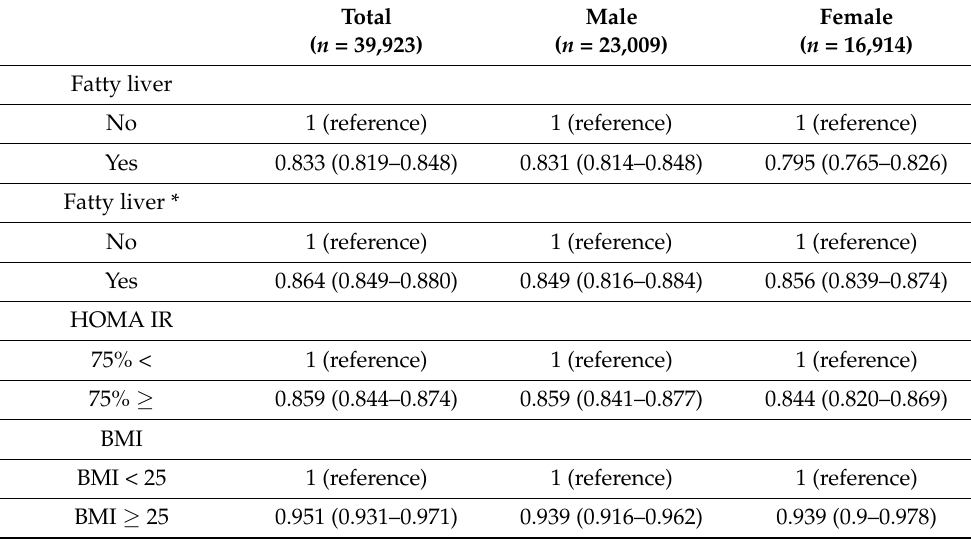
Table 4. Association between fatty liver, HOMA-IR index and BMI with NT-proBNP.